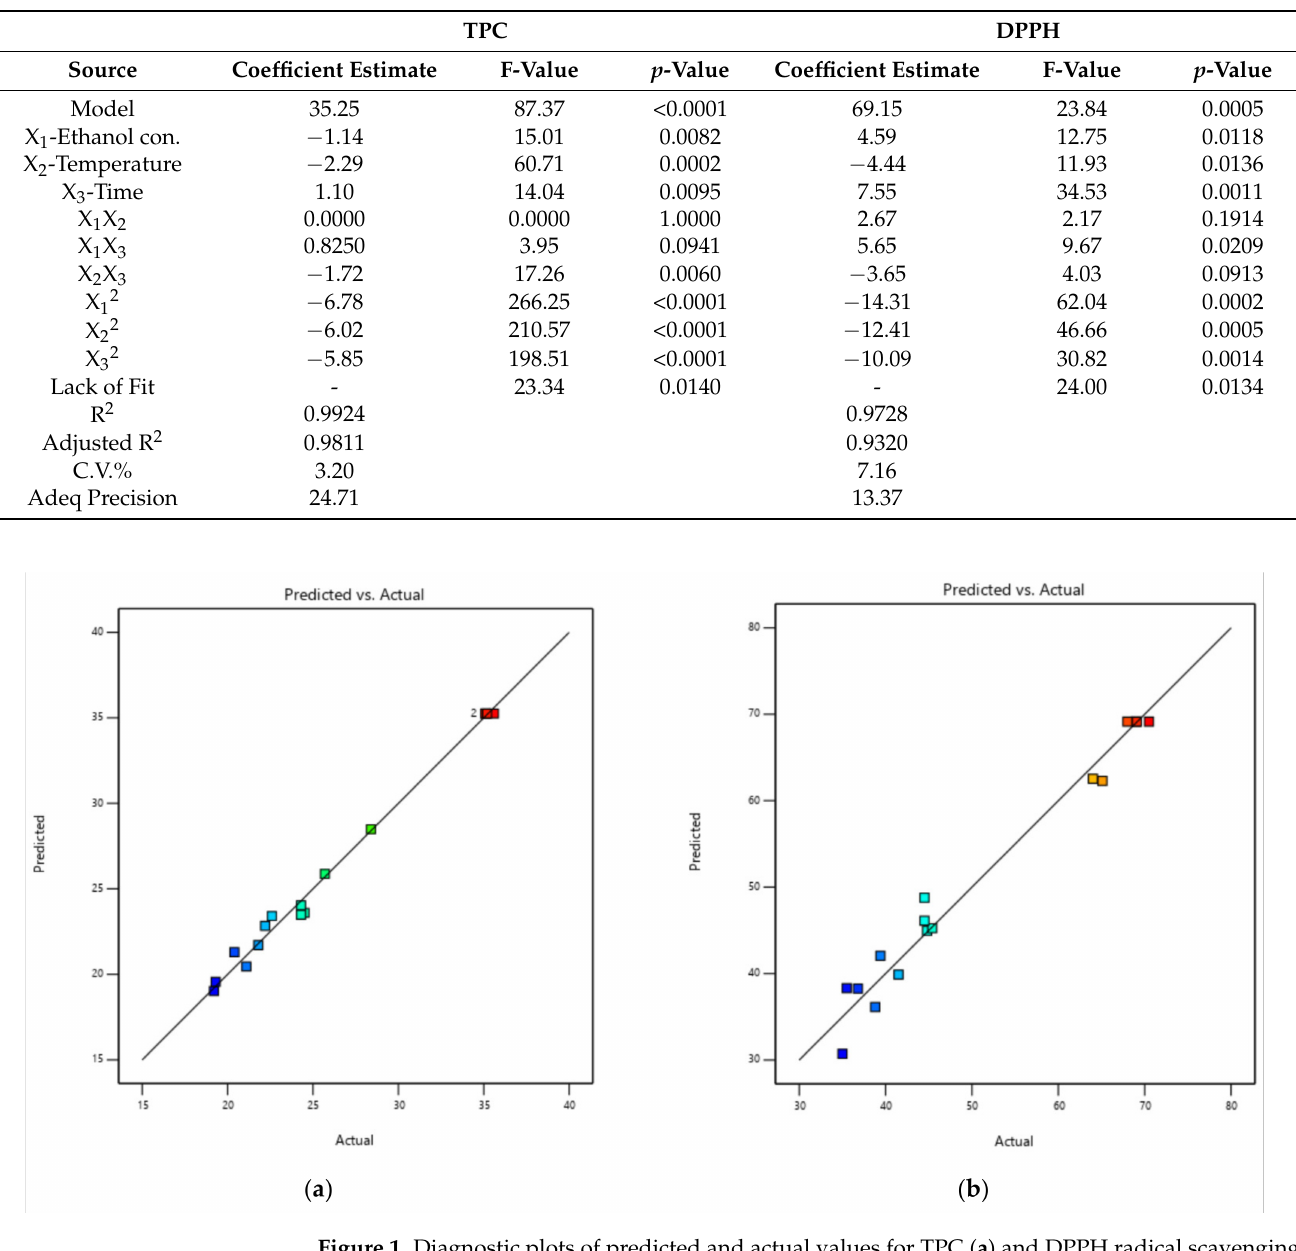
Figure 1. Diagnostic plots of predicted and actual values for TPC ( a ) and DPPH radical scavenging activity ( b